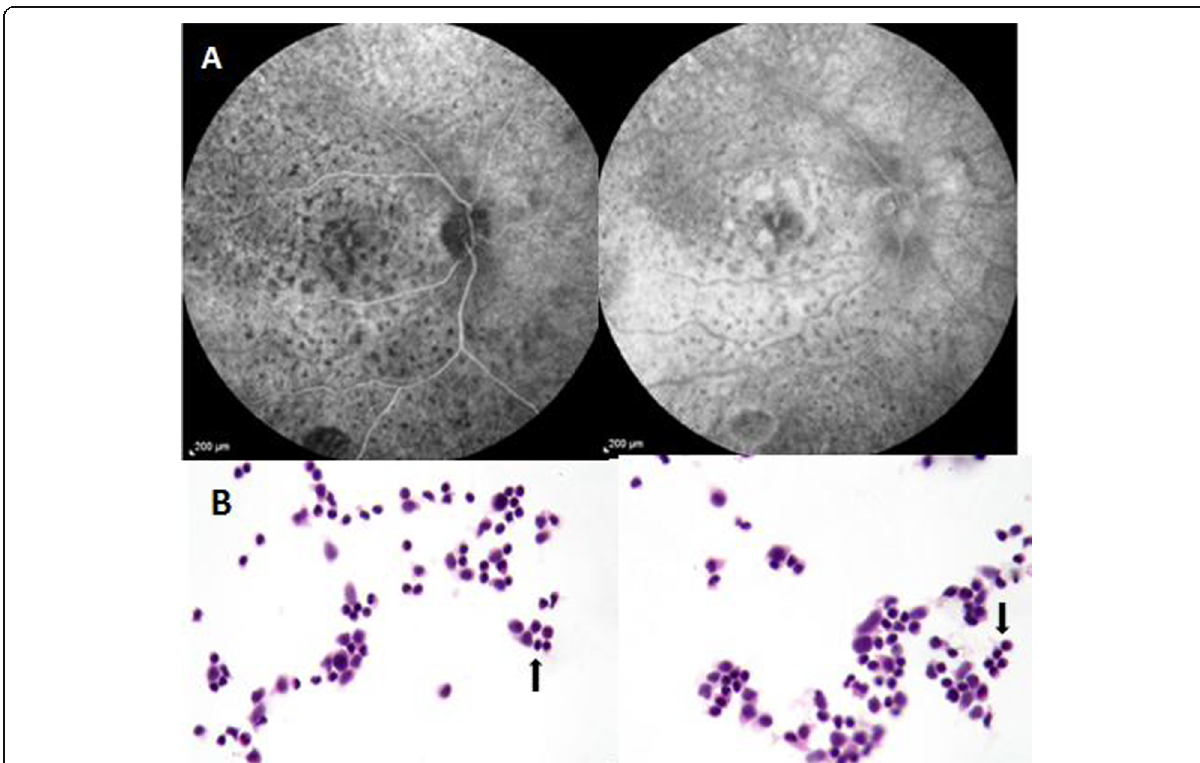
Fig. 2 Fluorescein angiography (FA) of right eye early and late phase which shows diffused multiple hypofluorescence dots in the form of a leopard-spot pigmentation within arteriovenous phase. A Cytopathology of the vitreous specimen (stained by H&E method) revealed infiltration of lymphoid cell with higher nucleus-cytoplasm ratio and nuclear atypia (Arrows) suggestive of malignant lymphoma.